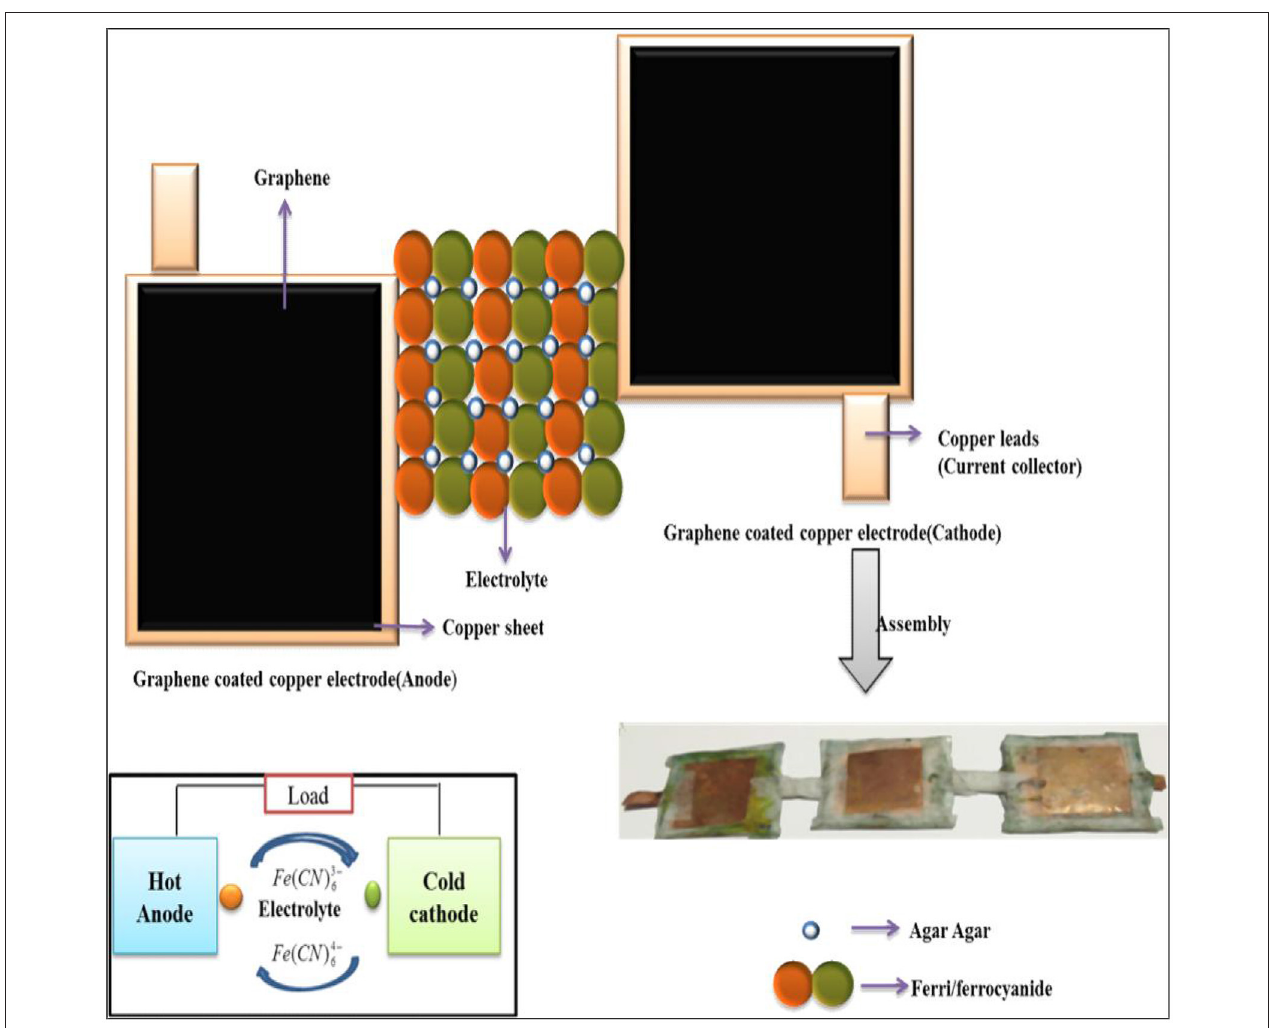
FIGURE 1 | Illustrative representation of the thermocells.